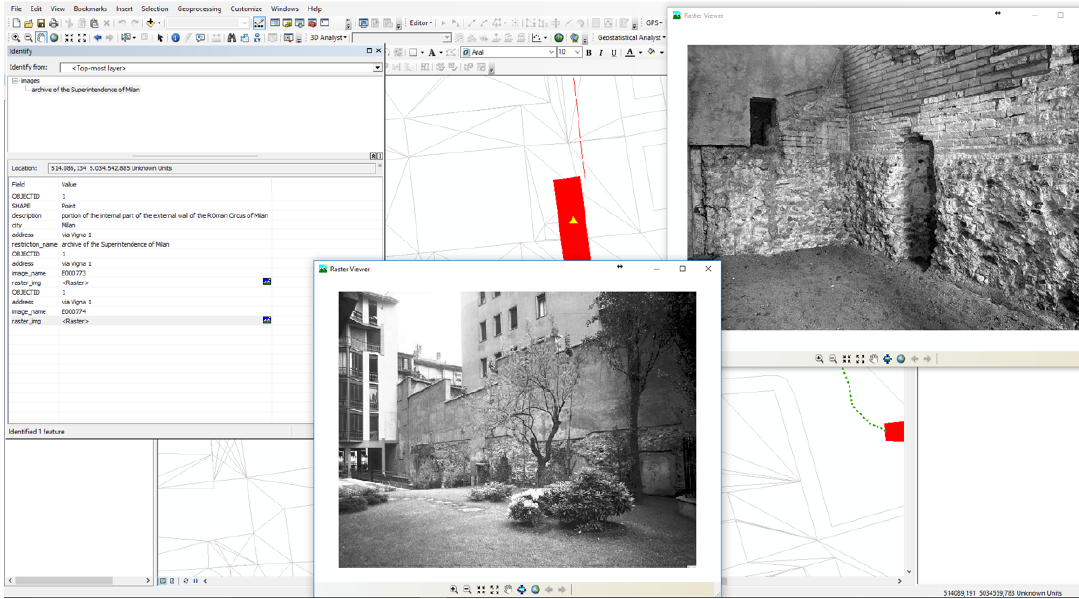
Figure 7. Geo Data Base for associating each piece of information such as historical images, reports or new 3D models originated by laser scanning and photogrammetry, in the same georeferenced